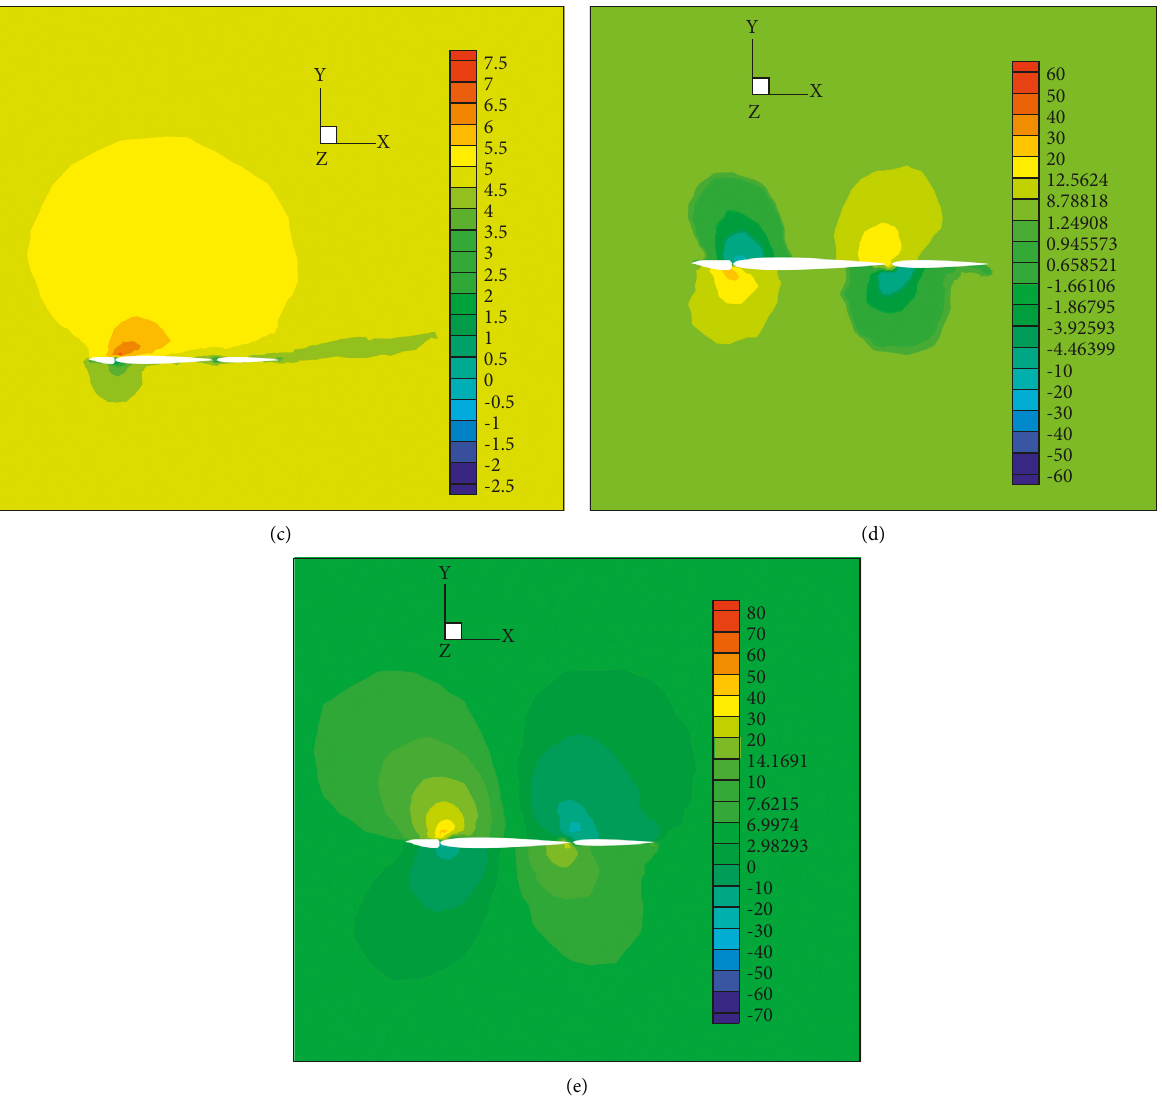
Figure 10: Velocity contours of the flapping wing robot. (a), (b) and (c): right view, top view and front view of the robot in the steady state; (d): front view in the transient state when the wing flaps upwards; (e): front view in the transient state when the wing flaps